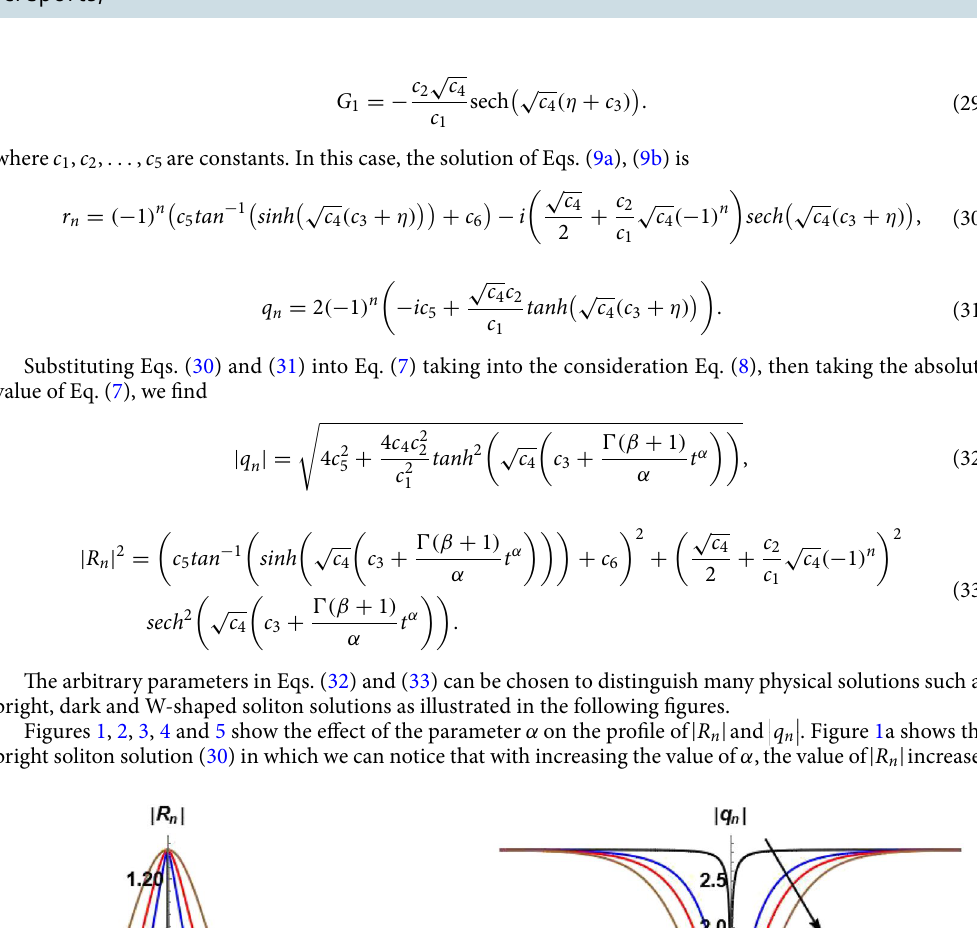
Figure 1. Plot of the solutions (32) and (33) when c 1 values of n for different values of α .